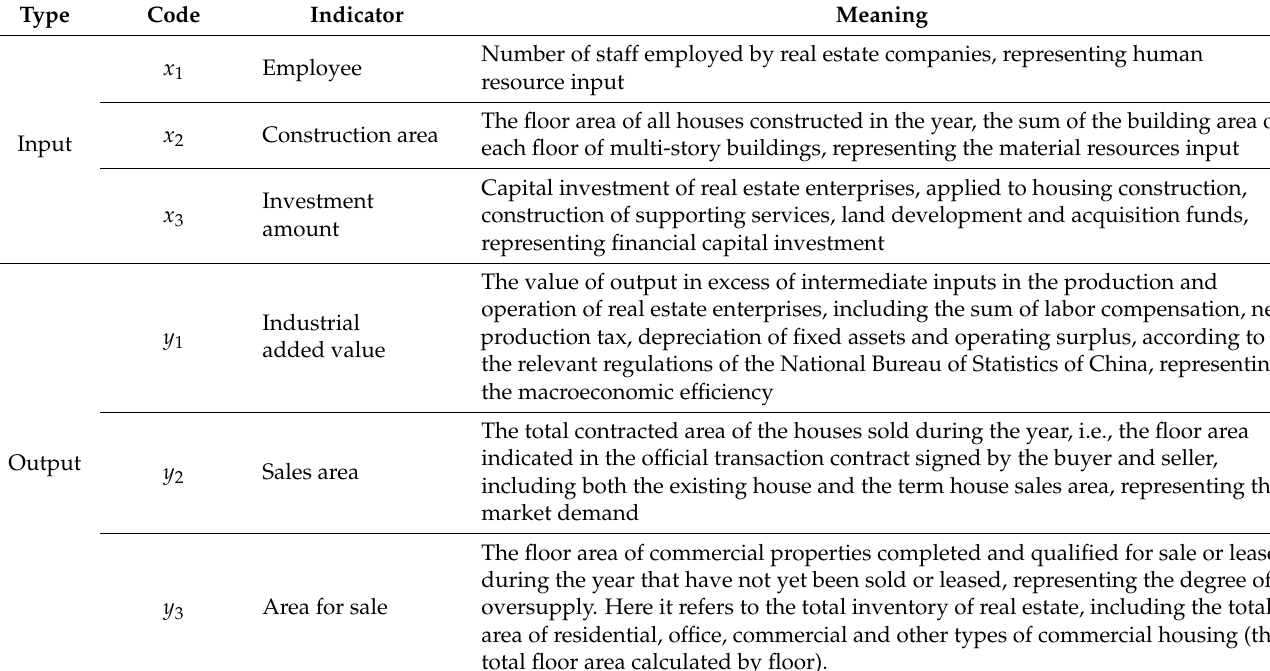
Table 1. Variable composition